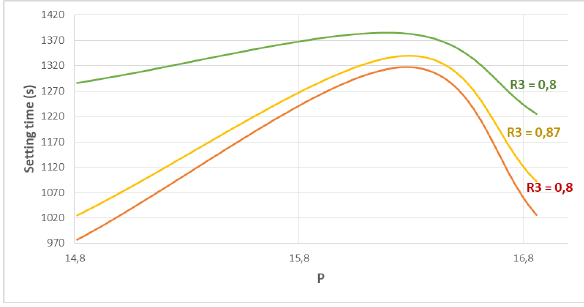
Figure 16: Effect of the structural parameters on the setting time